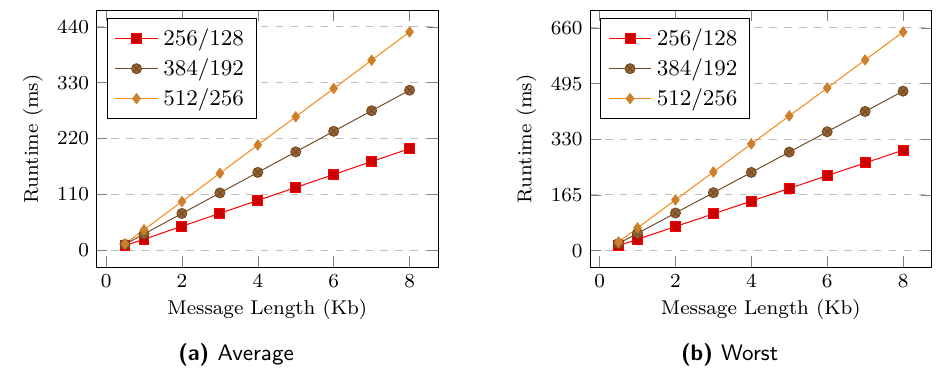
Figure 5: Runtimes of H sss with Variable Message Lengths.